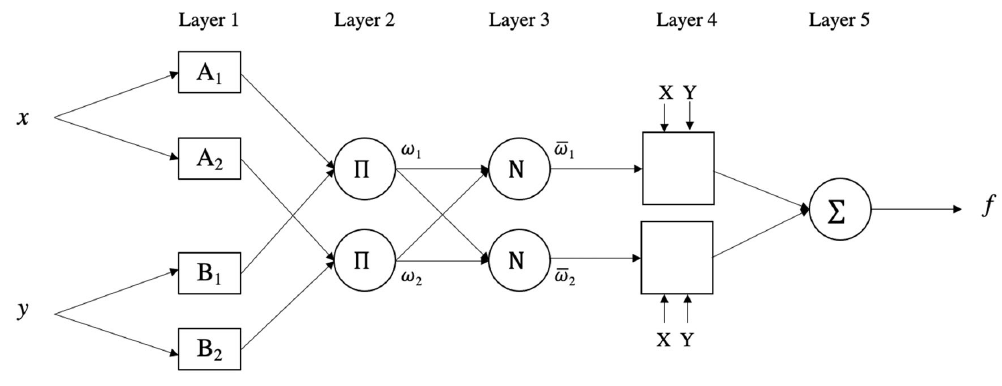
Figure 4. ANFIS architecture with two rules.